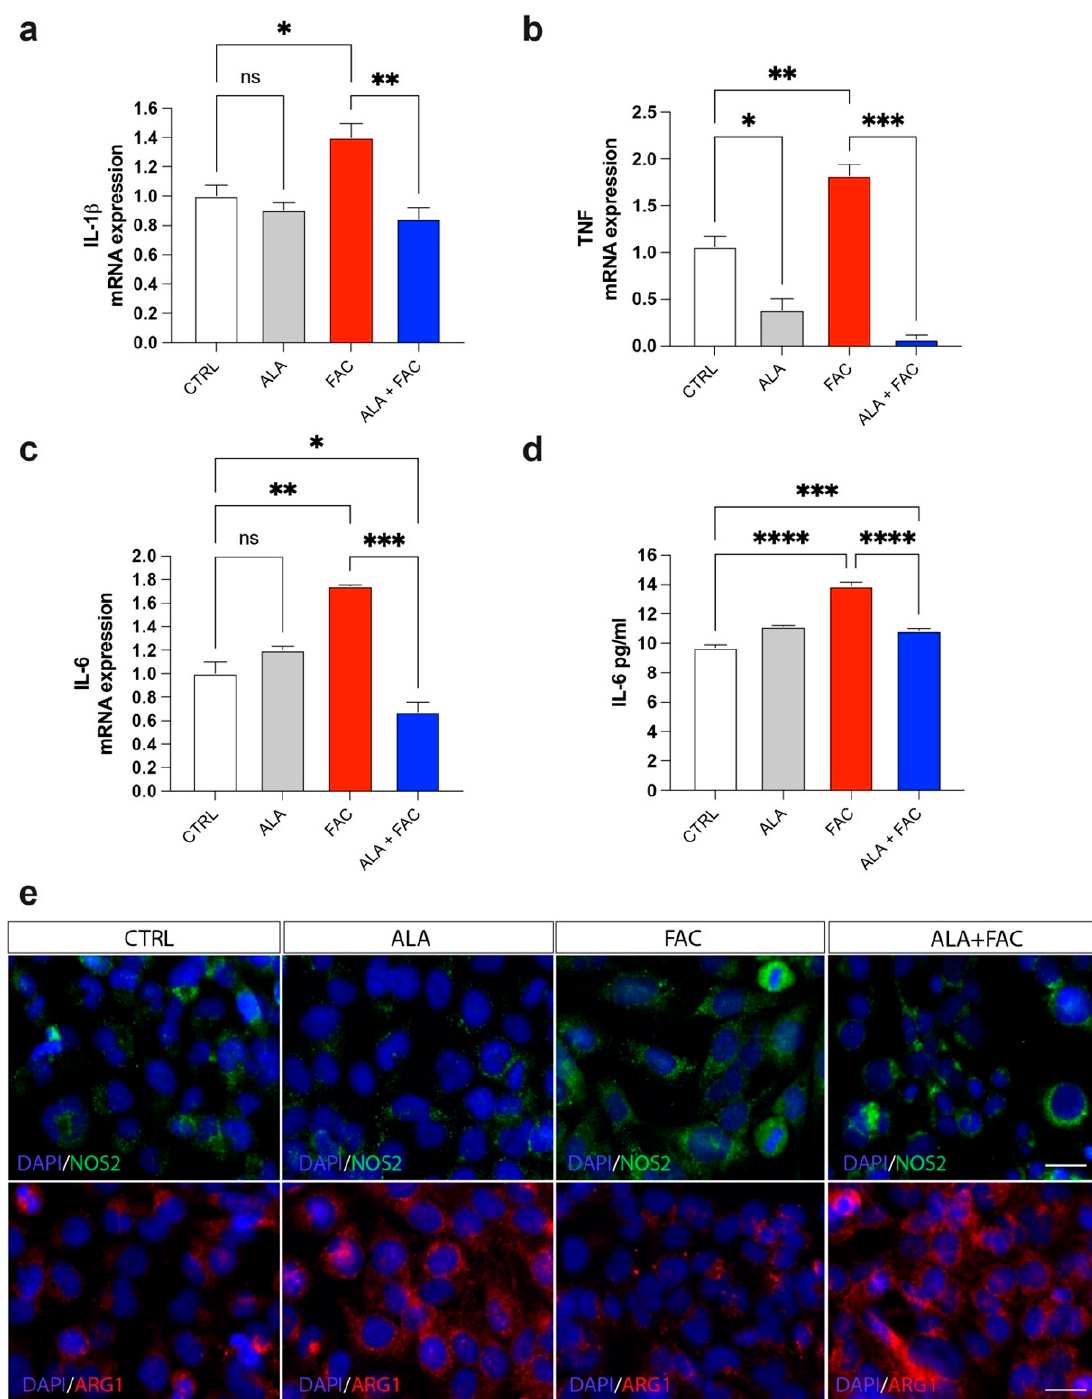
Figure 4. Iron overload induces microglia inflammatory phenotype reverted by ALA. ( a – c ) Quantification of mRNA expression levels of IL-1 β ( a ), TNF ( b ) and IL-6 ( c ) in control, ALA-, FAC- and ALA + FAC-treated HMC3 cells. ( d ) ELISA of IL-6 levels in the supernatant of control, ALA-, FAC- and ALA + FAC-treated HMC3 cells. ( e ) Representative pictures of immunofluorescence analysis of NOS2 and ARG1 in control, ALA-, FAC- and ALA + FAC-treated HMC3 cells. * p -value < 0.05; ** p -value < 0.01; *** p -value < 0.001; **** p -value < 0.0001.